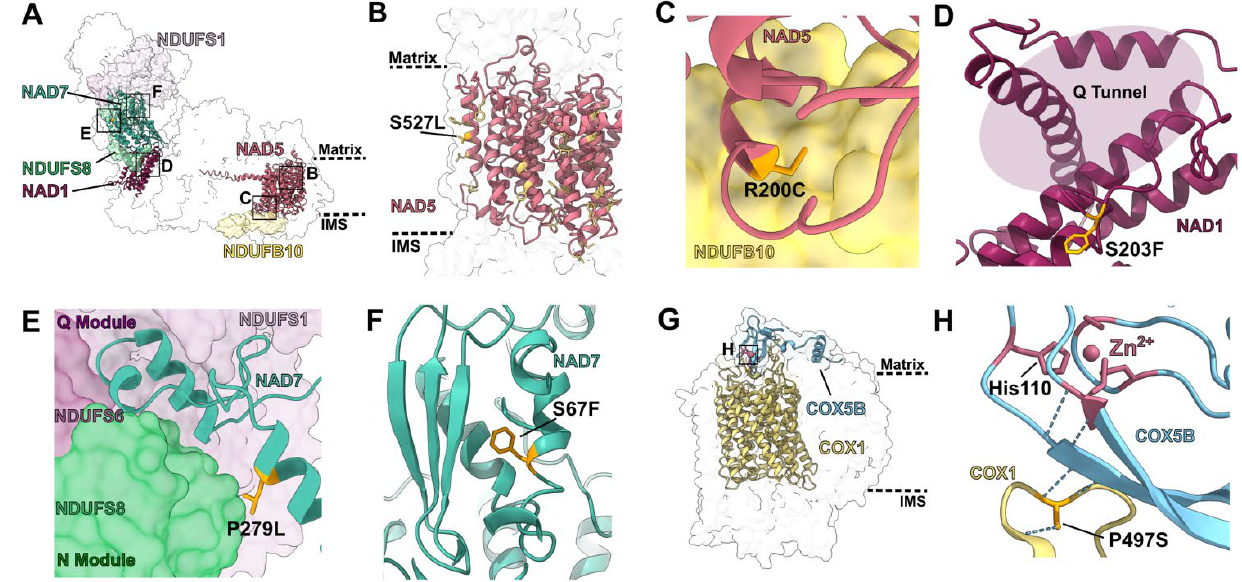
Figure 2. Structural characterization of edits by select single-site PPR proteins: ( A ) Overall position of the edits produced by PPR proteins MPR25, PpPPR_79, SMK1 and MEF9 in A. thaliana complex I (PDB: 7AR8). Edited subunits are shown in colored cartoon and interacting subunits are shown in colored surface over transparent complex I surface. Insets show the positions of panels ( B – F ). Approximate locations of the matrix and IMS are shown in dashed lines. ( B – F ) Structural details of edited residues. Edited residues are shown in orange stick representation. ( B ) NAD 5′ s transmembrane region (pink). NAD 5′ s residue 527, located in the inner mitochondrial membrane, is edited by MPR25 from a hydrophilic serine to a hydrophobic leucine (S527L). Other edited residues in the transmembrane region of NAD5 are colored in light yellow. ( C ) Interface between NAD5 (pink cartoon) and NDUFB10 (yellow surface). NAD5 residue 200 is edited by PpPPR_79 from arginine to cysteine (R200C). Editing of a bulky to a small residue allows this helix to fit in the crowded interface. ( D ) NAD 1′ s residue 203, located in a loop close to the quinone tunnel, is edited from serine to phenylalanine (S203F) by DEK605. Editing to a more hydrophobic residue improves the stability of this buried loop and its ability to bind quinone. ( E ) Interface between NAD7 (teal cartoon, Q module) with NDUFS8 (light green surface, Q module), NDUFS6 (dark purple surface, N module), NDUFS1 (light purple surface, N module). NAD 7′ s residue 279 is edited by SMK1 from proline to leucine (P279L). Destabilization of the helix of L279 would impair the interaction between the N and Q modules of complex I. ( F ) NAD 7′ s residue 67 is edited from serine to phenylalanine (S67F) by MEF9. Given that this position is not in the membrane, the change to a hydrophobic residue does not have a significant advantage. ( G ) Overall position of the edit produced by SMK4 in V. radiata complex IV (PDB: 7JRO). Edited subunit (COX1) is shown in yellow cartoon and interacting subunit (COX5B) is shown in light blue cartoon over transparent complex IV surface. Insets show the positions of panels ( H ). Approximate locations of the matrix and IMS are shown in dashed lines. ( H ) COX 1′ s residue 497 is edited by SMK4 from a proline to a serine (P497S). Serine-497 forms multiple hydrogen bonds (dashed light blue lines) that help position the Zn 2+ -coordinating residues of COX5B (pink sticks, pink atom). MPR25 edits NAD5 (cid:48) s serine-527 to leucine (Figure 2B). NAD5 is a